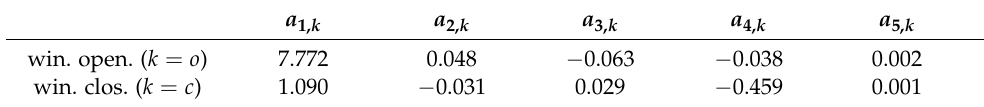
Table 1. Coefficients of the multivariate logistic regression model for window human control. a 1, k a 2, k a 3, k a 4, k a 5, k win. open. ( k = o ) 7.772 0.048 − 0.063 − 0.038 0.002 win. clos. ( k = c ) 1.090 − 0.031 0.029 − 0.459 0.001